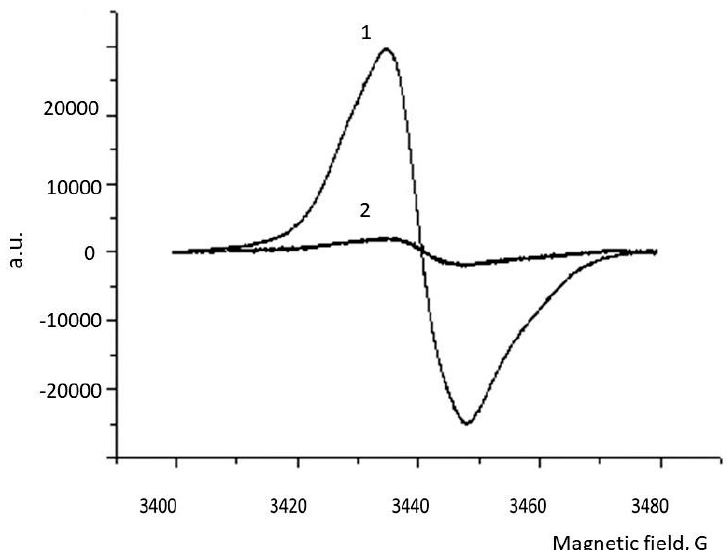
Figure 3. ESR spectrum of ommochromes from BSF. Curve 1—the initial spectrum; curve 2—after oxidation with 1% hydrogen peroxide solution during 2 h. Table 3. ESR characteristics of BSF suspension of ommochromes in 0.1 M K-phosphate buffer (pH 7.4) at liquid nitrogen temperature (measurements were made at 77 K, P = 0.02 mW). g- The Concentration of Paramagnetic ∆ H pp Sample Factor Centers, 10 17 Spin/g Dry Weight Sample